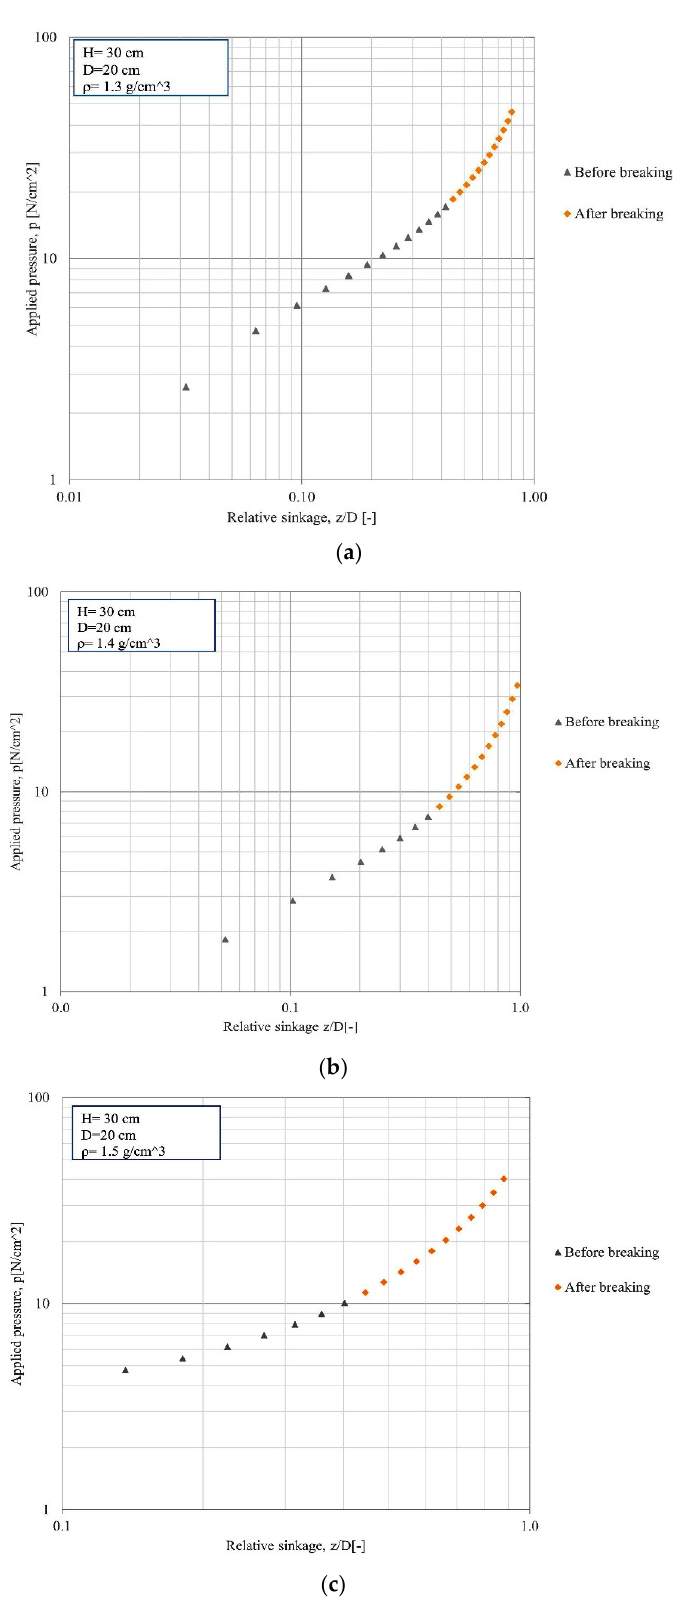
Figure 4. Pressure–sinkage curves for a soil thickness level of 30 cm at bulk densities of ( a ) 1.3 g/cm 3 , ( b ) 1.4 g/cm 3 , and ( c ) 1.5 g/cm 3 .